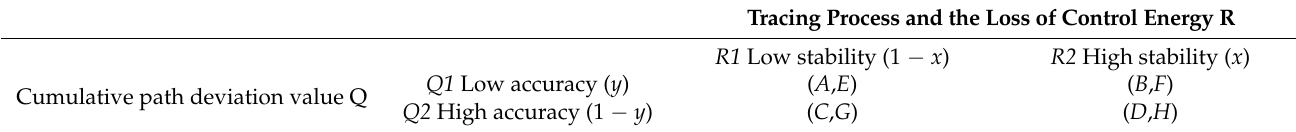
Table 3. Gain matrix of the hybrid strategy game with Q and